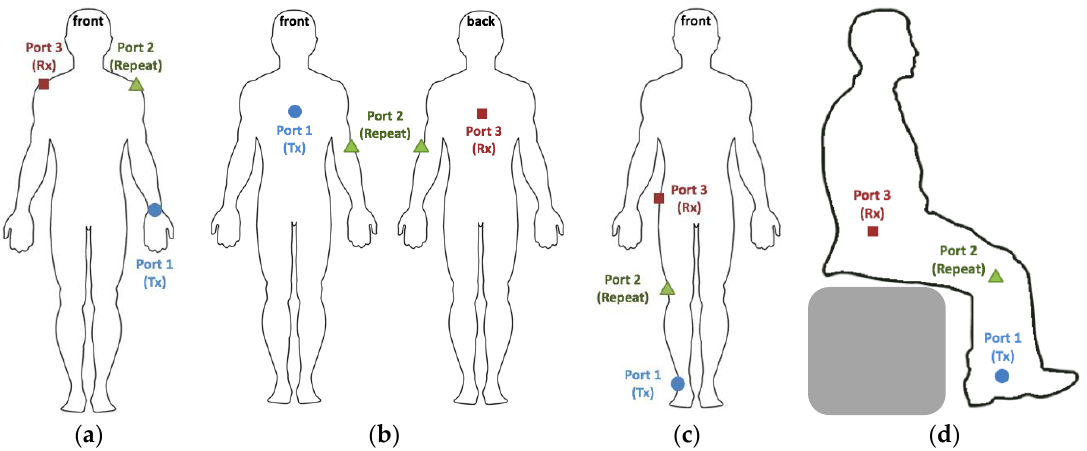
Figure 7. On-body repeater test scenarios: ( a ) wrist to opposite shoulder, ( b ) chest to back, ( c ) ankle to hip in upright pose, and ( d ) ankle to hip in sitting position.